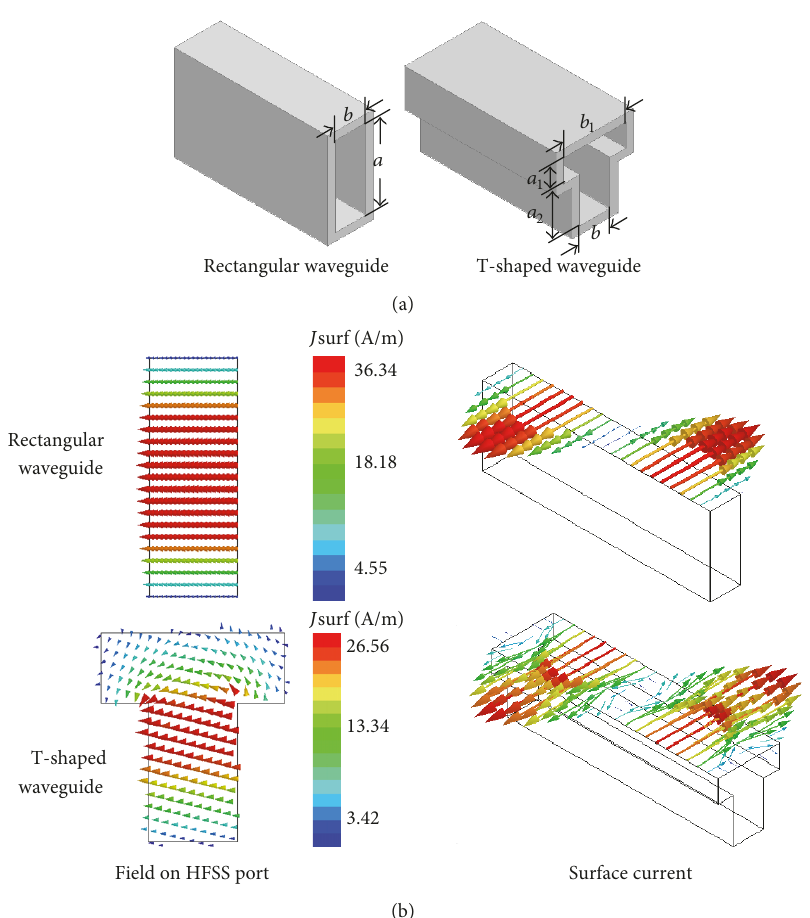
Figure 1: Geometry and field distributions of the rectangular and T-shaped waveguide. (a) Configuration. (b) Port field in dominant mode and surface current on the top